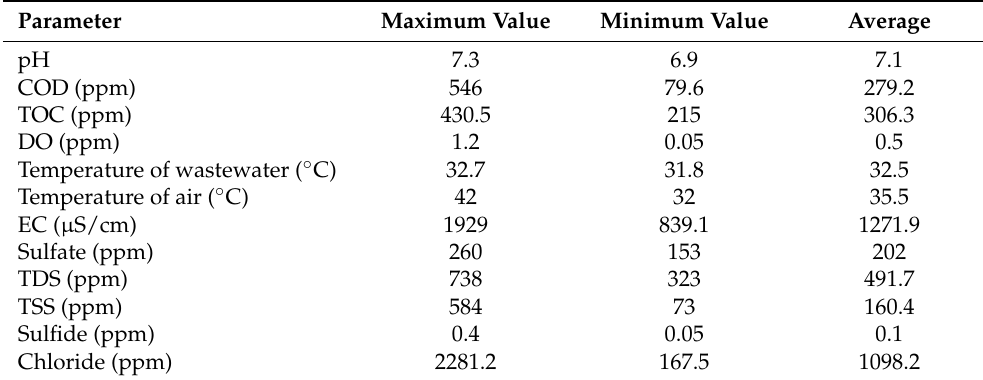
Table 1. The maximum, minimum, and average values of wastewater